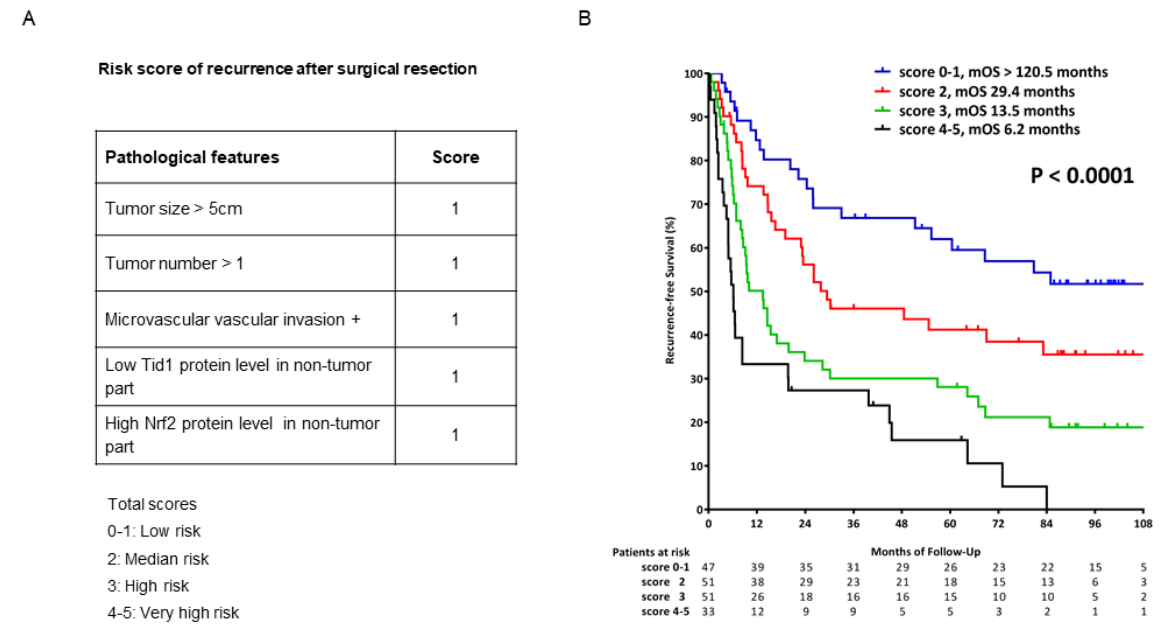
Figure 4. Recurrence-free survival of the HCC patients stratified into four groups based on the scoring system. ( A ) Prognostic score established by incorporation of the five factors: tumor size, tumor number, vascular invasion, low Tid1 protein level, and high Nrf2 protein level in the non-tumor part. ( B ) Recurrence-free survival of HCC patients according to the established prognostic score.